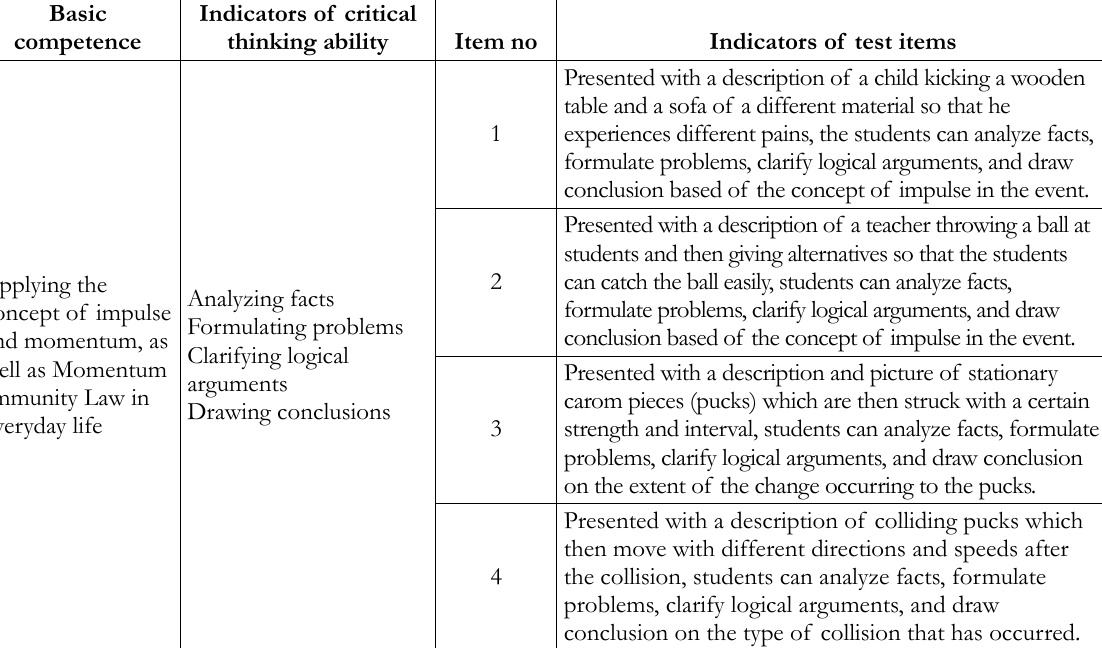
Table 2. Indicators of critical thinking in the topic of momentum and impulse